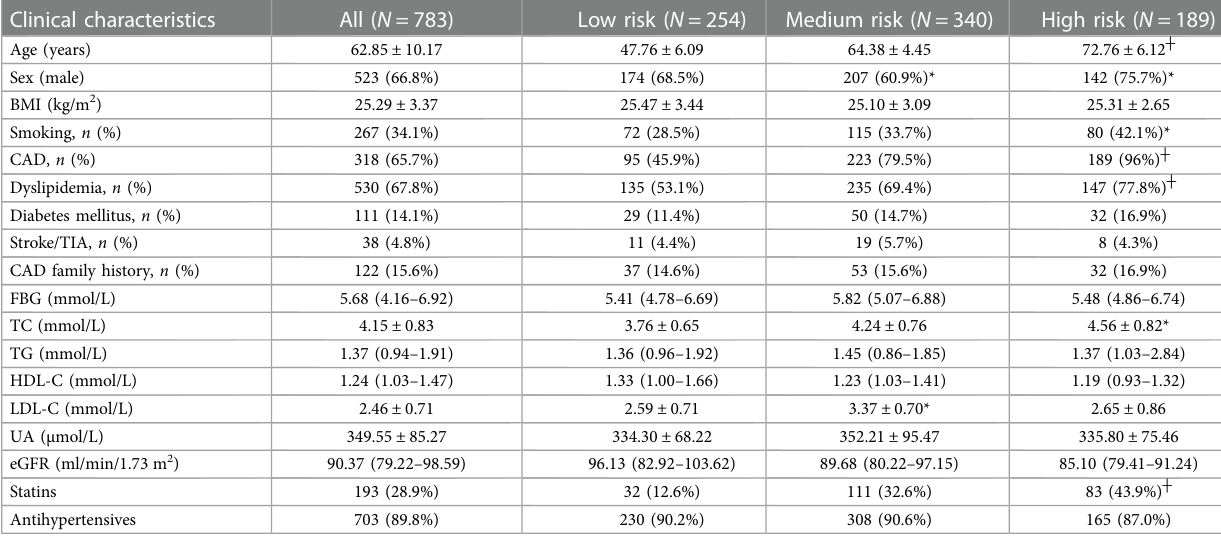
TABLE 1 Patient characteristics across the different groups of Leiden score. Clinical